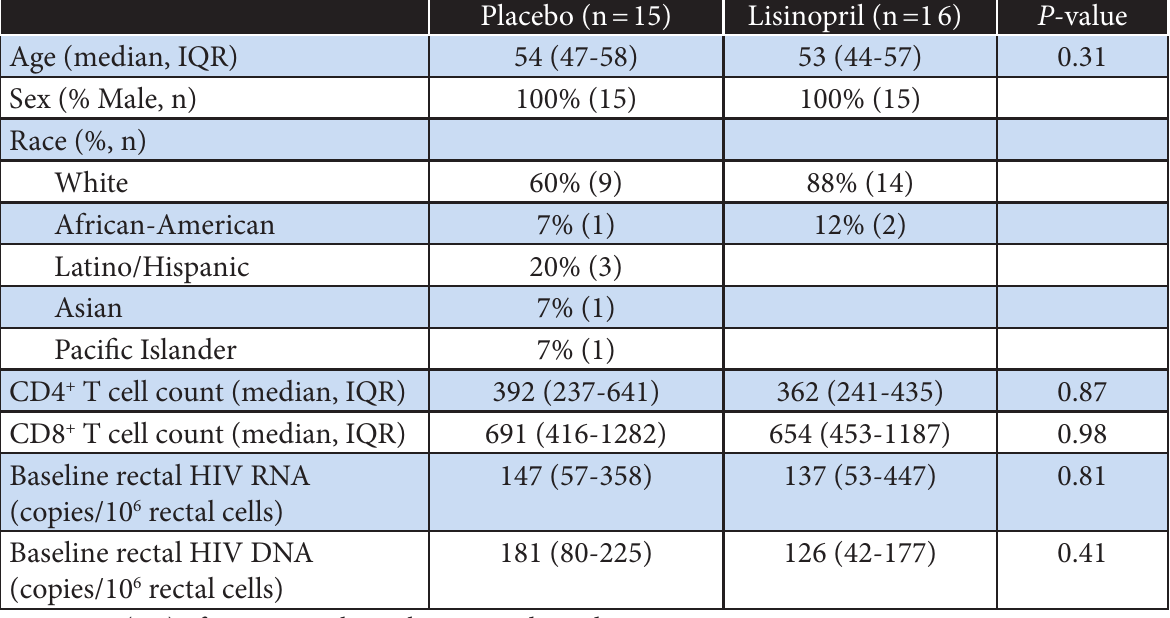
Table 1: Baseline